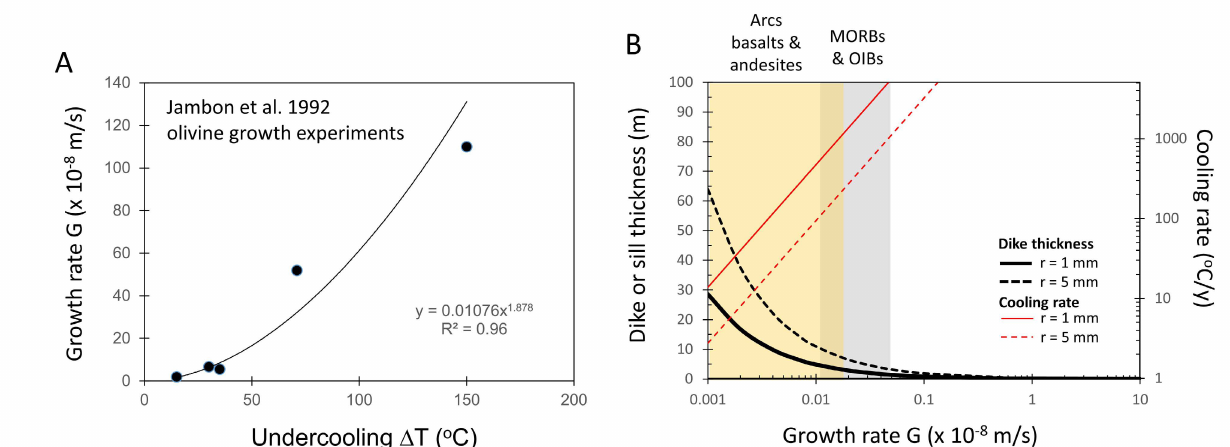
Figure 11: [A] Olivine growth experiments of Jambon et al. [1992] showing growth rate versus degree of undercooling, e.g. temperature below liquidus. Curved line represents a regression of the data using an exponential function. [B]Model results showing how growth rate relates to dike/sill thickness (black bold lines) and initial cooling rate (thin red lines). Left hand axis refers to dike/sill thickness and right-hand axis for cooling rate. Dashed lines correspond to the hypothetical case in which characteristic olivine radius is 5 mm. Solid lines are for olivine radius of 1 mm, which is the typical length scale of olivine phenocrysts. Note that cooling rate corresponds to the effective cooling rate over which olivine grows and does not reflect the long-term cooling rate of the dike. Vertical shaded regions correspond to the range of growth rates estimated from Δ PEFA in Figure